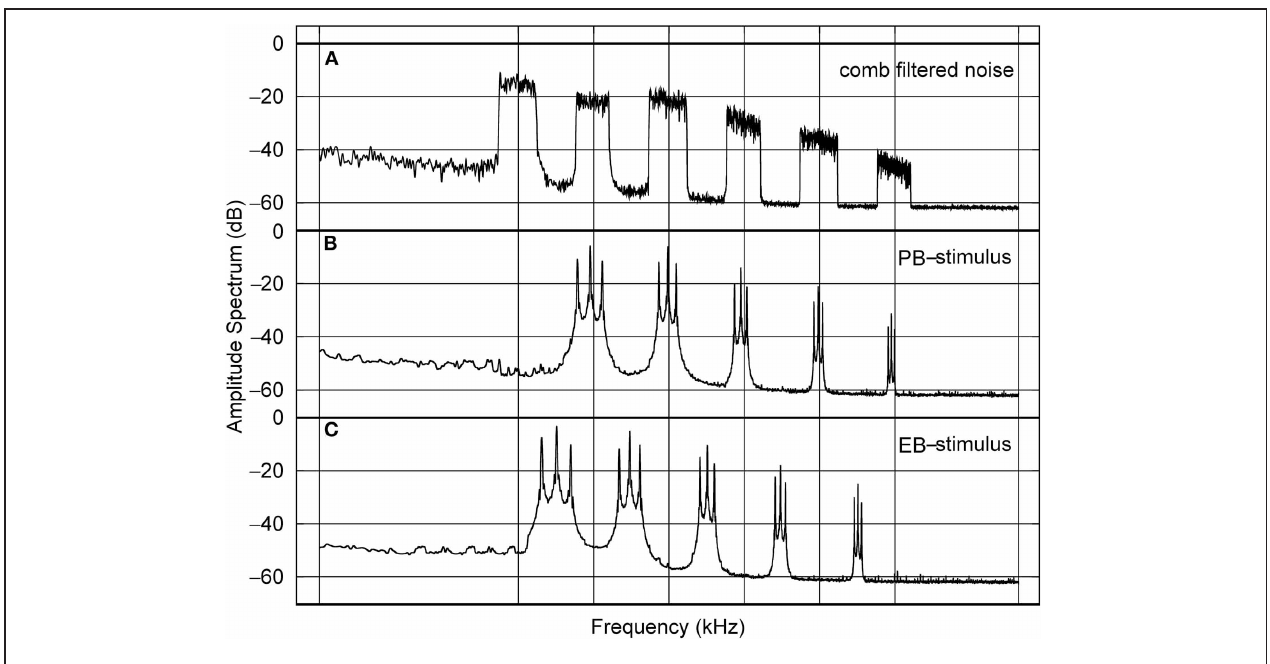
FIGURE 4 | ( Modified from Pantev et al., 2004 ) Amplitude spectra of the comb filtered noise (CFN), the pass-band stimulus (PB), and the eliminated-band stimulus (EB) (rows a, b, and c, respectively). The